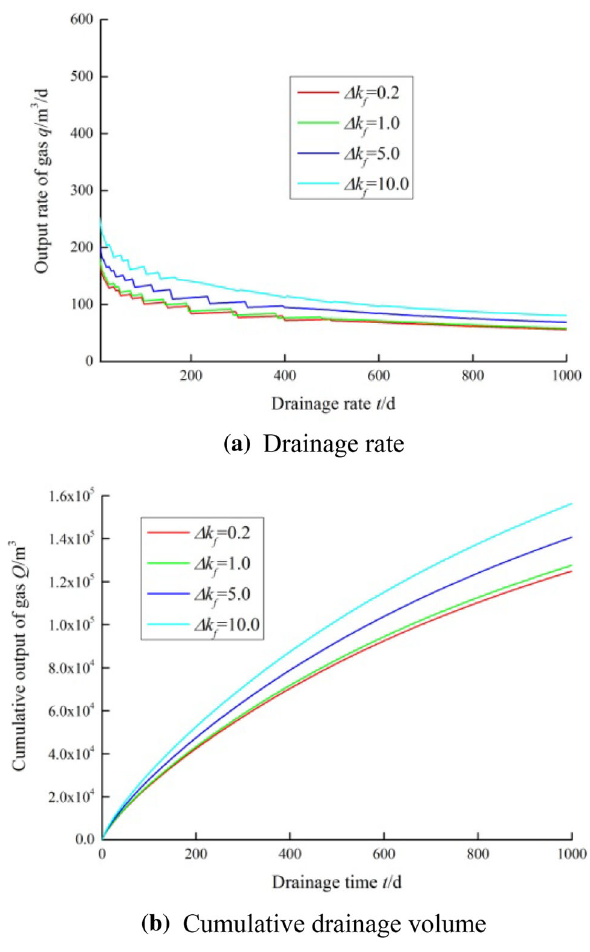
Fig. 10 Output rate and cumulative output of gas in coal seams with different permeability (coal seam temperature is 30 (cid:3) C)